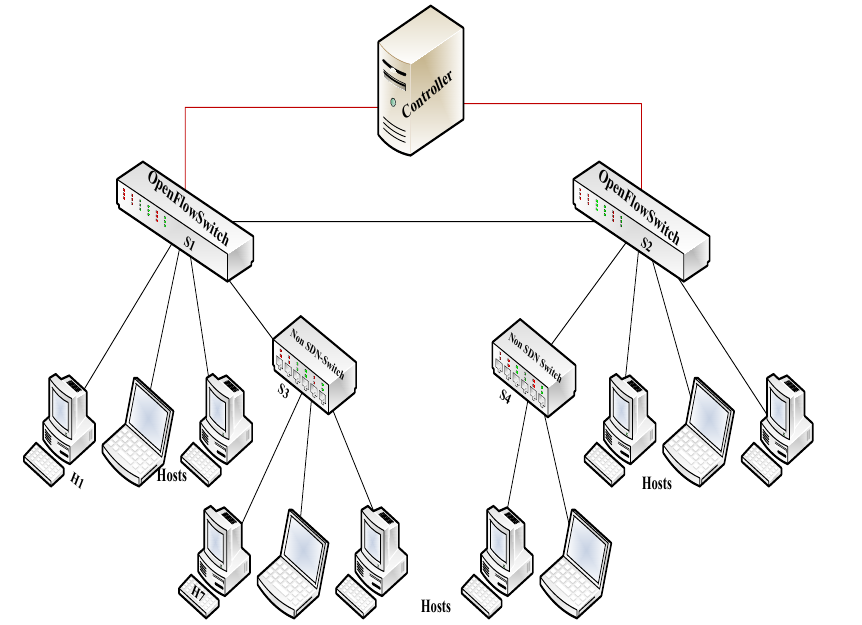
Figure 5. Multiple SDN Switches Scenario (M3S).